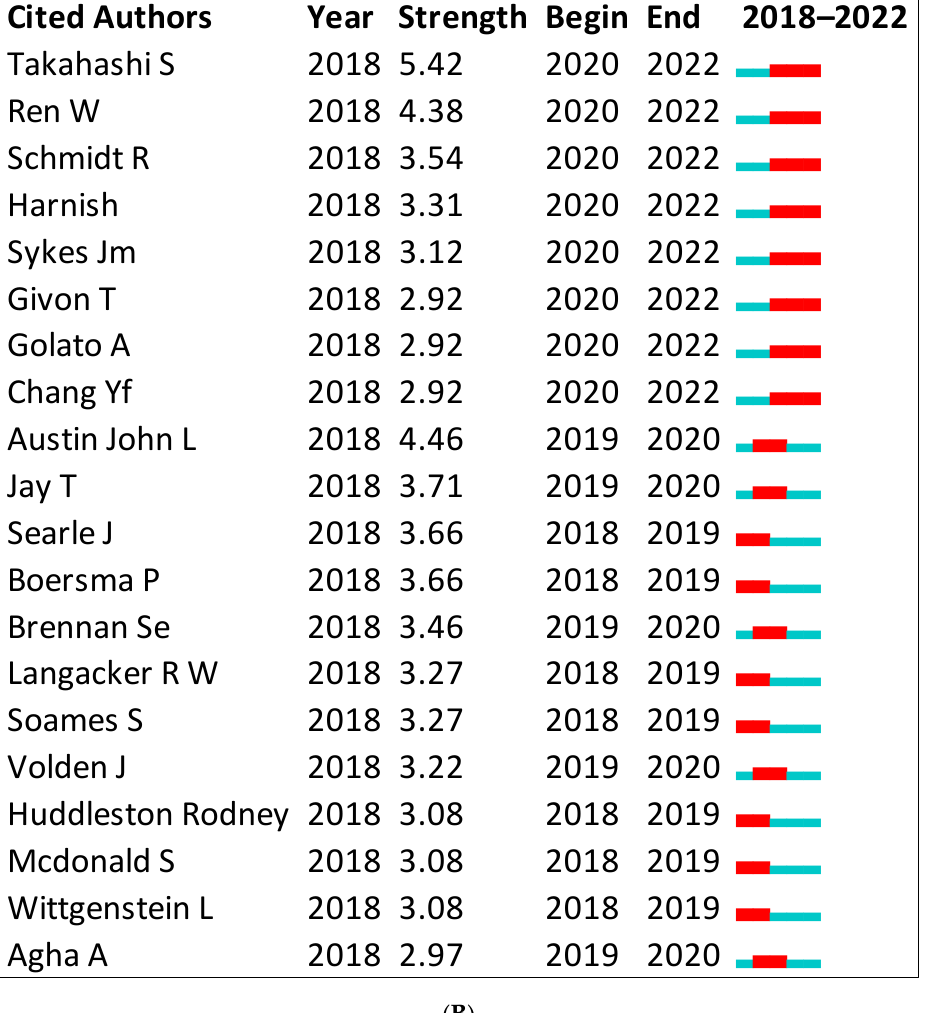
Figure 12. Top 20 authors with the strongest citation bursts. ( A ) (Scopus). ( B ) (WOS).